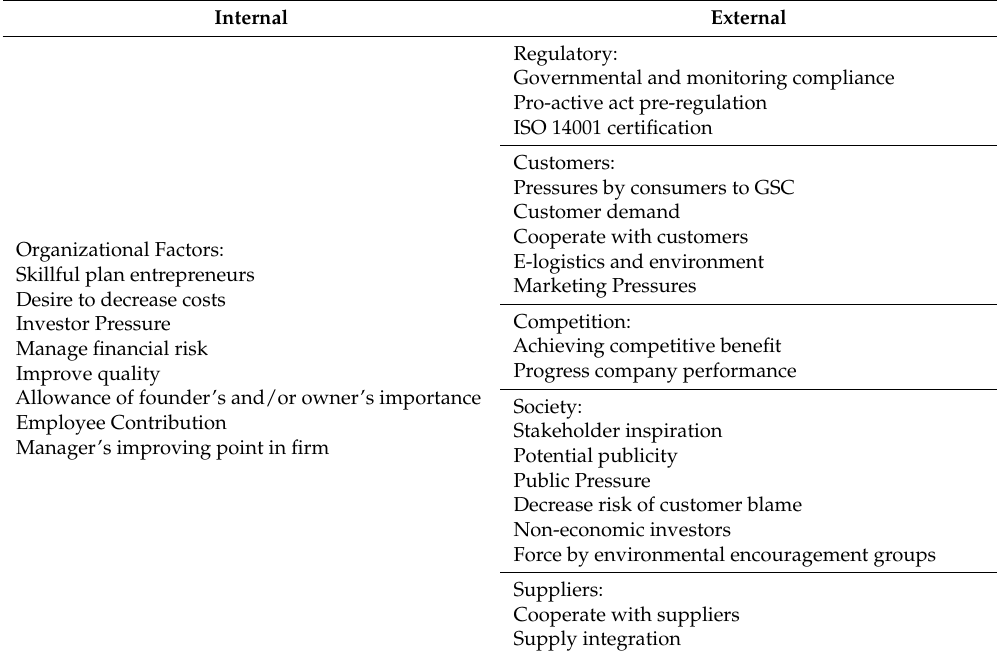
Table 1. Drivers of